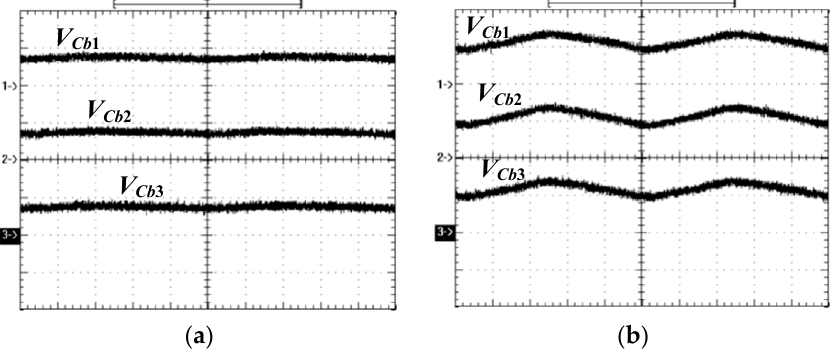
Figure 11. Measured secondary side currents at ( a ) 20% load [ i D 1 , i D 2 , i Lo 1 , i Lo 2 , i Lo 1 + i Lo 2 : 10 A/div; time: 2 µs]; ( b ) 100% load [ i D 1 , i D 2 , i Lo 1 + i Lo 2 : 50 A/div; i Lo 1 , i Lo 2 : 20 A/div; time: 2 µs].